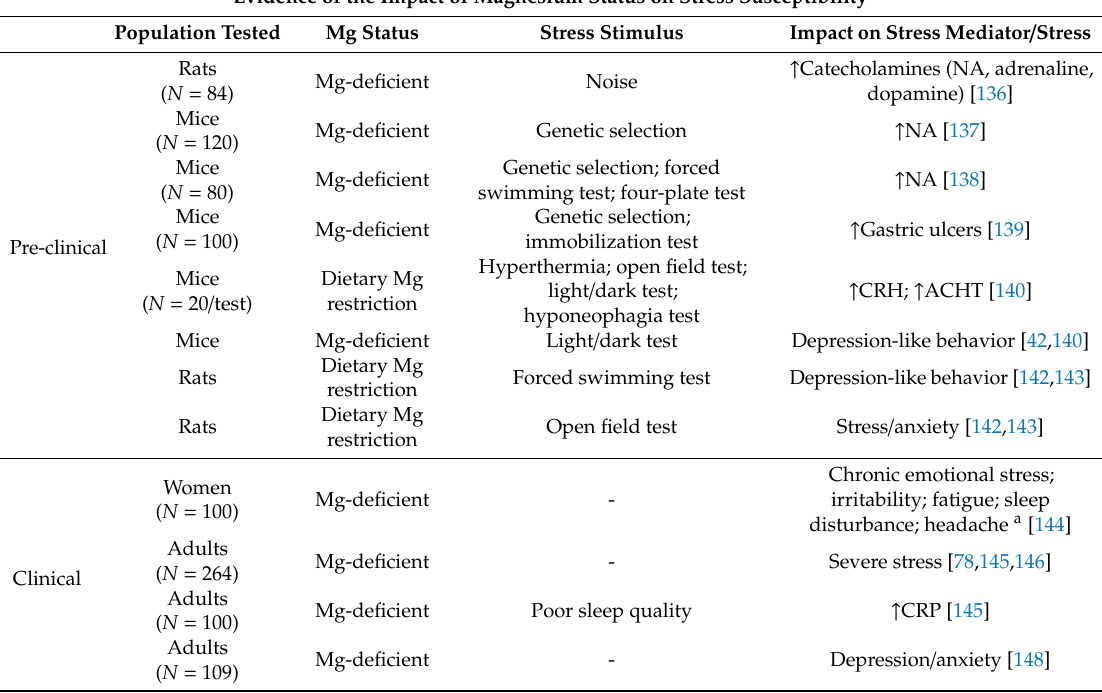
Table 5. Summary of the pre-clinical and clinical evidence supporting magnesium status on stress susceptibility. a Only symptoms shown in ≥ 70% of women at baseline are